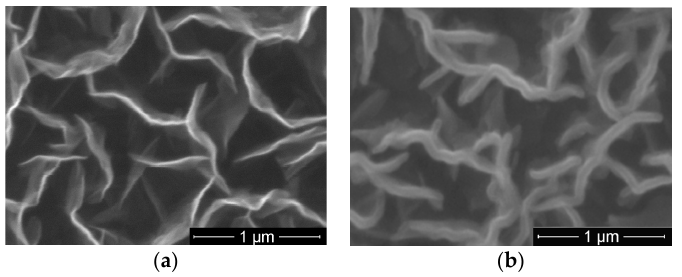
Figure 5. SEM images of carbon nanowalls (CNW) ( a ) as-deposited; and ( b ) covered by PTFE layer deposited by magnetron sputtering.